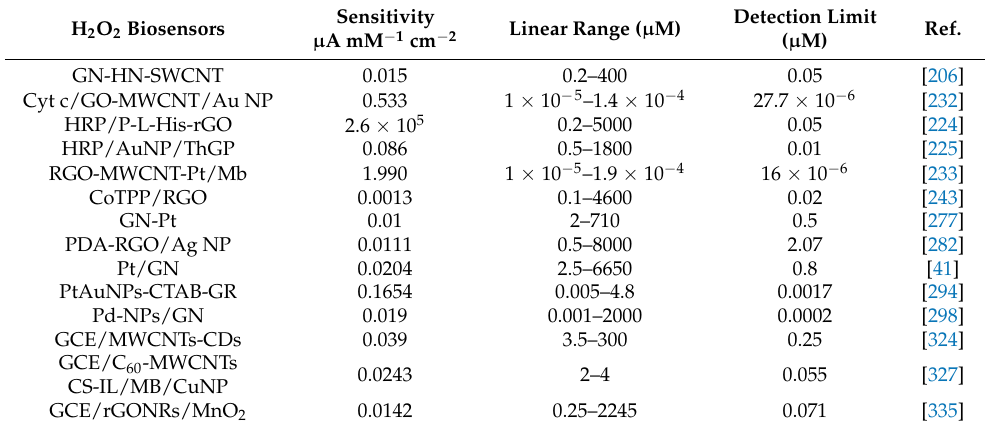
Figure 7. Mechanism of metal nanoparticle loaded CNTs for real-time analyses of H 2 O 2 secreted from live cells. Reproduced with permission from [324], Copyright 2016 Spinger Ltd (Berlin/Heidelberg, Germany). Table 6. Ultra-sensitive electrochemical biosensors for detection of H 2 O 2